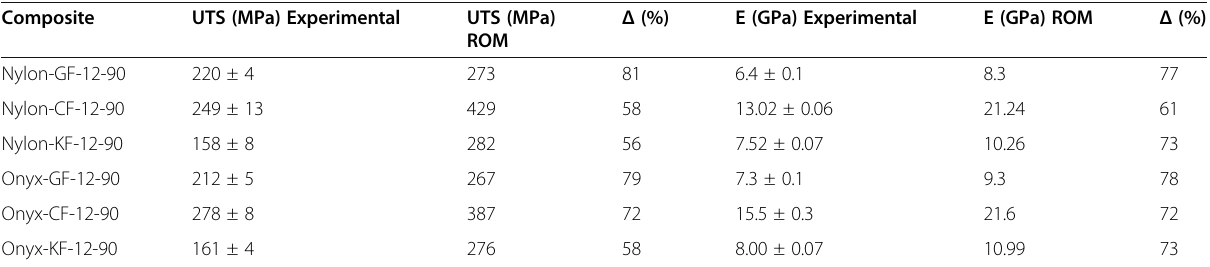
Table 6 Comparison of Experimental Values for UTS and E Against Calculated Values. Δ is Experimental value as a % of ROM value